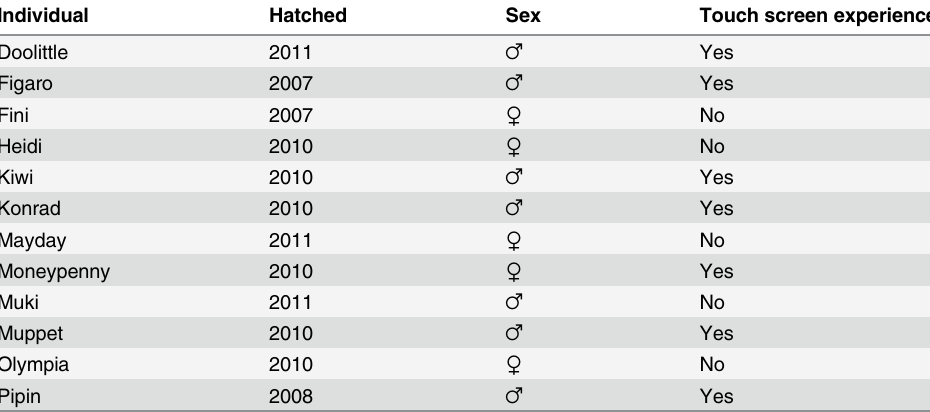
Pipin 2008 ♂ Yes Names of individuals are listed in the fi rst column, with year of hatching and sex in the following columns; the last column (Touch screen experience) refers to whether individuals have participated in prior discrimination tasks on the touch